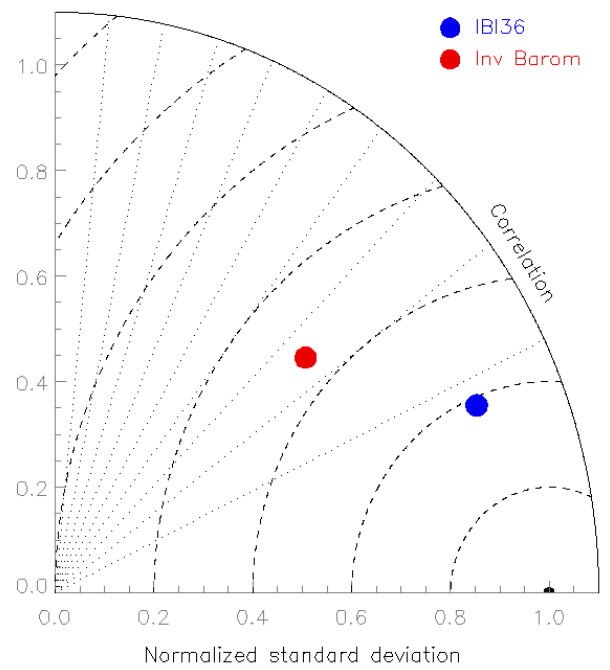
Figure 12: Taylor diagram for comparisons between tide gauge data and the model residual elevations (blue) and the inverse barometer (red). Results are computed for periods below 10 days and for data located in the Bay of Biscay and in the English Channel. The radial coordinate indicates the standard deviation normalized by the data standard deviation; the concentric circles represent the RMS differences for time series normalized by the data standard deviation (the observations are indicated with the black point) and the angular coordinate represents the correlation with observations.